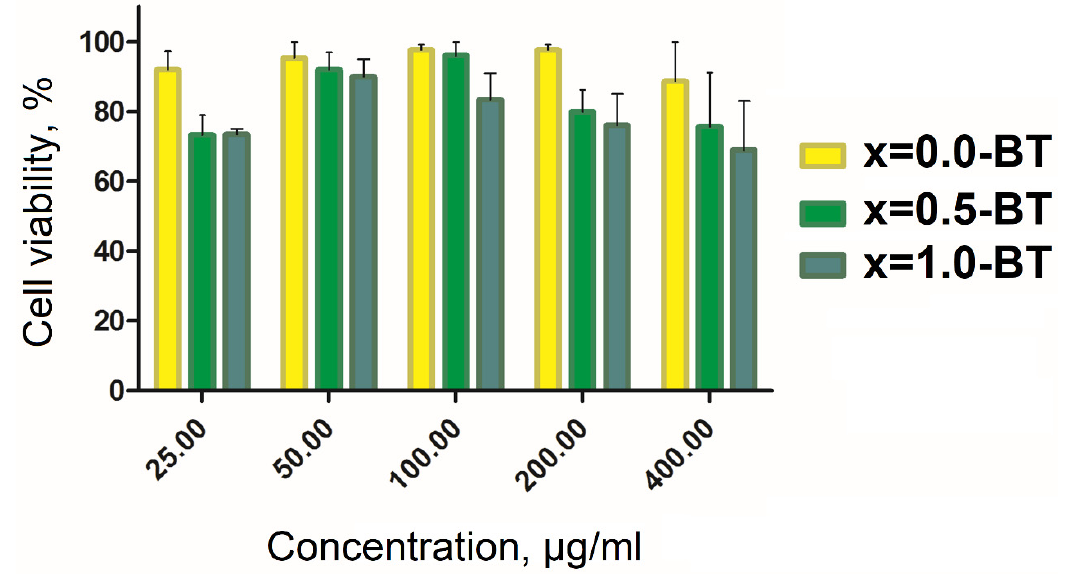
Figure 11. Cytotoxicity study for the samples of x = 0.0-BT, x = 0.5-BT, and x = 1.0-BT on CT-26 cancer cell line.